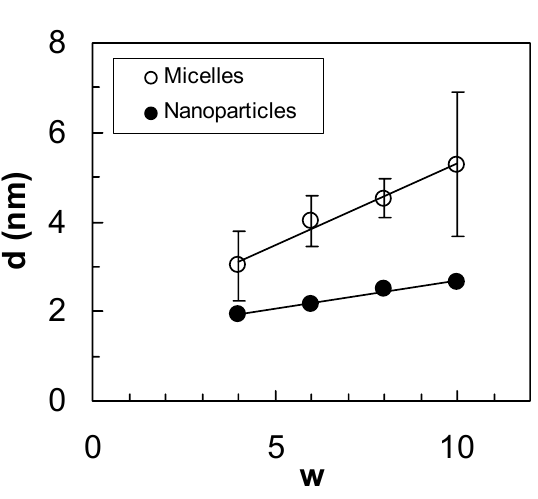
Fig. 6 Comparison of the diameters of the reverse micelles measured by DLS and those of CdSe nanoparticles calculated from the Visible spectra in Fig. 4c. The error bars give the statistical error from three independent measurements. The solid lines are fits of the